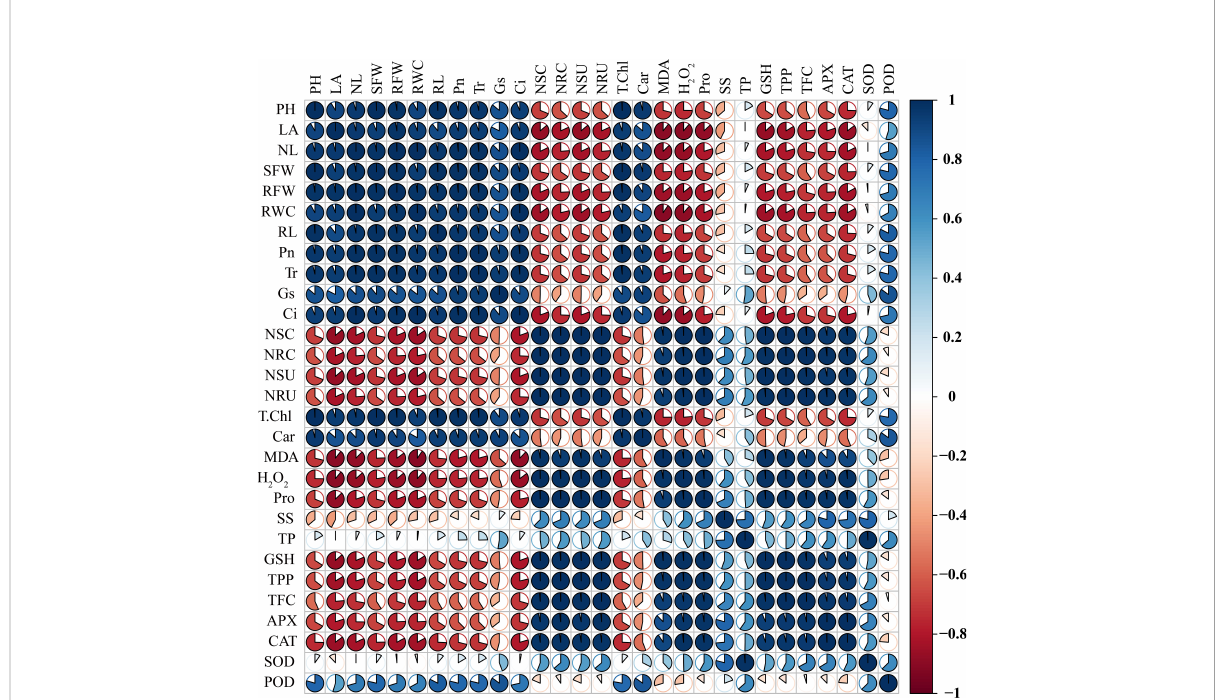
FIGURE 11 Pearson ’ s correlation analysis ( p < 0.05) was measured between different traits of sweetpotato. PH, plant height; LA, leaf area; NL, number of leaves; SFW, shoot FW; RFW, root FW; RWC, relative water content; RL, root length; RV, root volume; Pn, photosynthetic assimilation; Tr, transpiration rate; Gs, stomatal conductance; Ci, Intercellular CO 2 ; NSC, Ni shoot concentration; NRC, Ni root concentration; NSU, Ni shoot uptake; NRU, Ni root uptake; T. Chl, total chlorophyll; Car, carotenoids; MDA, malonaldehyde; H 2 O 2 , hydrogen peroxide; Pro, proline. SS, soluble sugars; TP, total proteins; GSH, reduced glutathione; TPP, total polyphenols; TFC, total fl avonoids; APX, ascorbate peroxidase; CAT, catalase; SOD, superoxide dismutase; and POD,